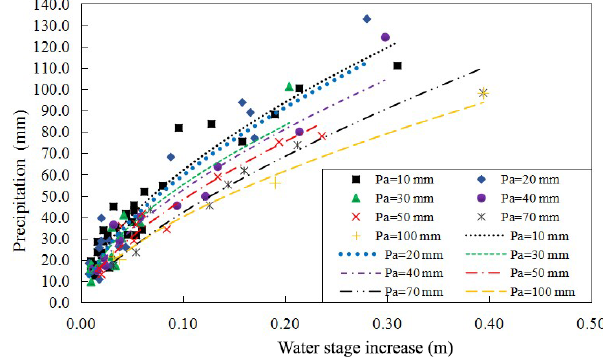
Figure 7. P − P a − R curve. Sluice into Taihu lake from Yangtze River for storing water resources of non-flood season after 2002. However, monthly water stage variation decreased 0.01 m in August for the same monthly multi-year average precipitation after 2002,